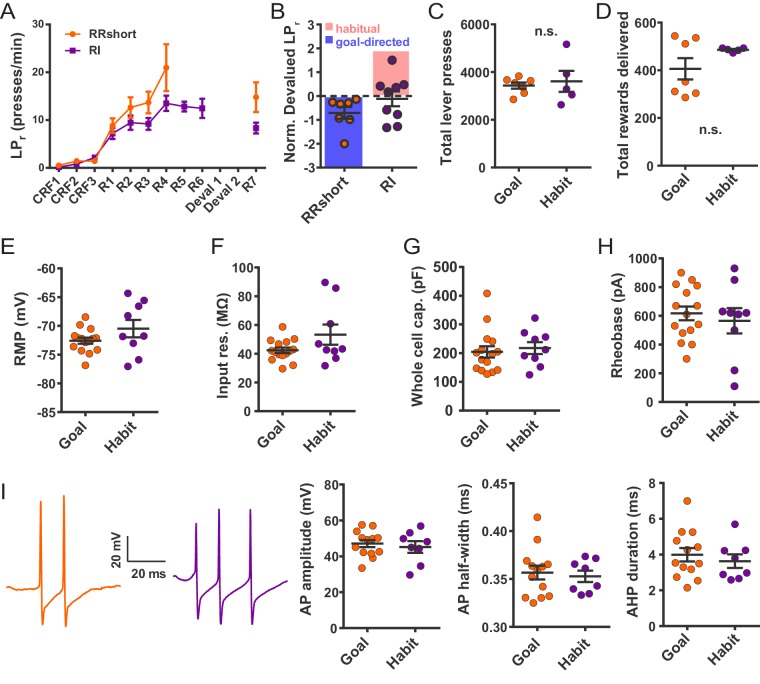
Electrophysiological properties of FSIs from habitual and goal-directed mice.(A) Learning curves showing lever press rate over training sessions. Mice acquired lever pressing behavior with continuous reinforcement (CRF) of lever presses and were then trained on either random interval (RI) or abbreviated random ratio (RRshort) reinforcement schedules to induce habitual and goal-directed behavior, respectively. A final training session was administered after devaluation testing, and 0–24 hr prior to recording, to mitigate any effects of devaluation testing. (B) Inclusion criteria for analysis of electrophysiological data. RRshort-trained mice that expressed goal-directed behavior (NDLPr <0) and RI-trained mice that expressed habitual behavior (NDLPr ≥0) were included. Mice that expressed modes of behavioral control inconsistent with training, that is, NDLPr <0 for RI-trained mice, were excluded from analysis. (C–D) Goal-directed (orange) and habitual (purple) mice used for group-wise comparisons of electrophysiological properties did not differ in total number of lever presses (p=0.72, n = 7 and 5 mice) or number of rewards delivered (p=0.72, n = 7 and 5 mice, Mann-Whitney U test) over the course of training. (E–H) Passive membrane properties of FSIs in slices from goal-directed and habitual mice. No differences were found for any membrane property (p=0.13, 0.081, 0.67, 0.58, n = 15 and 9 cells). (I) Left to right: representative action potential traces and quantification of action potential amplitude, half-width, and afterhyperpolarization current duration for FSIs from goal-directed and habitual mice. No difference was detected for any waveform property (p=0.60, 0.71, 0.53 n = 13 and 8 cells). Data are represented as mean ±SEM.